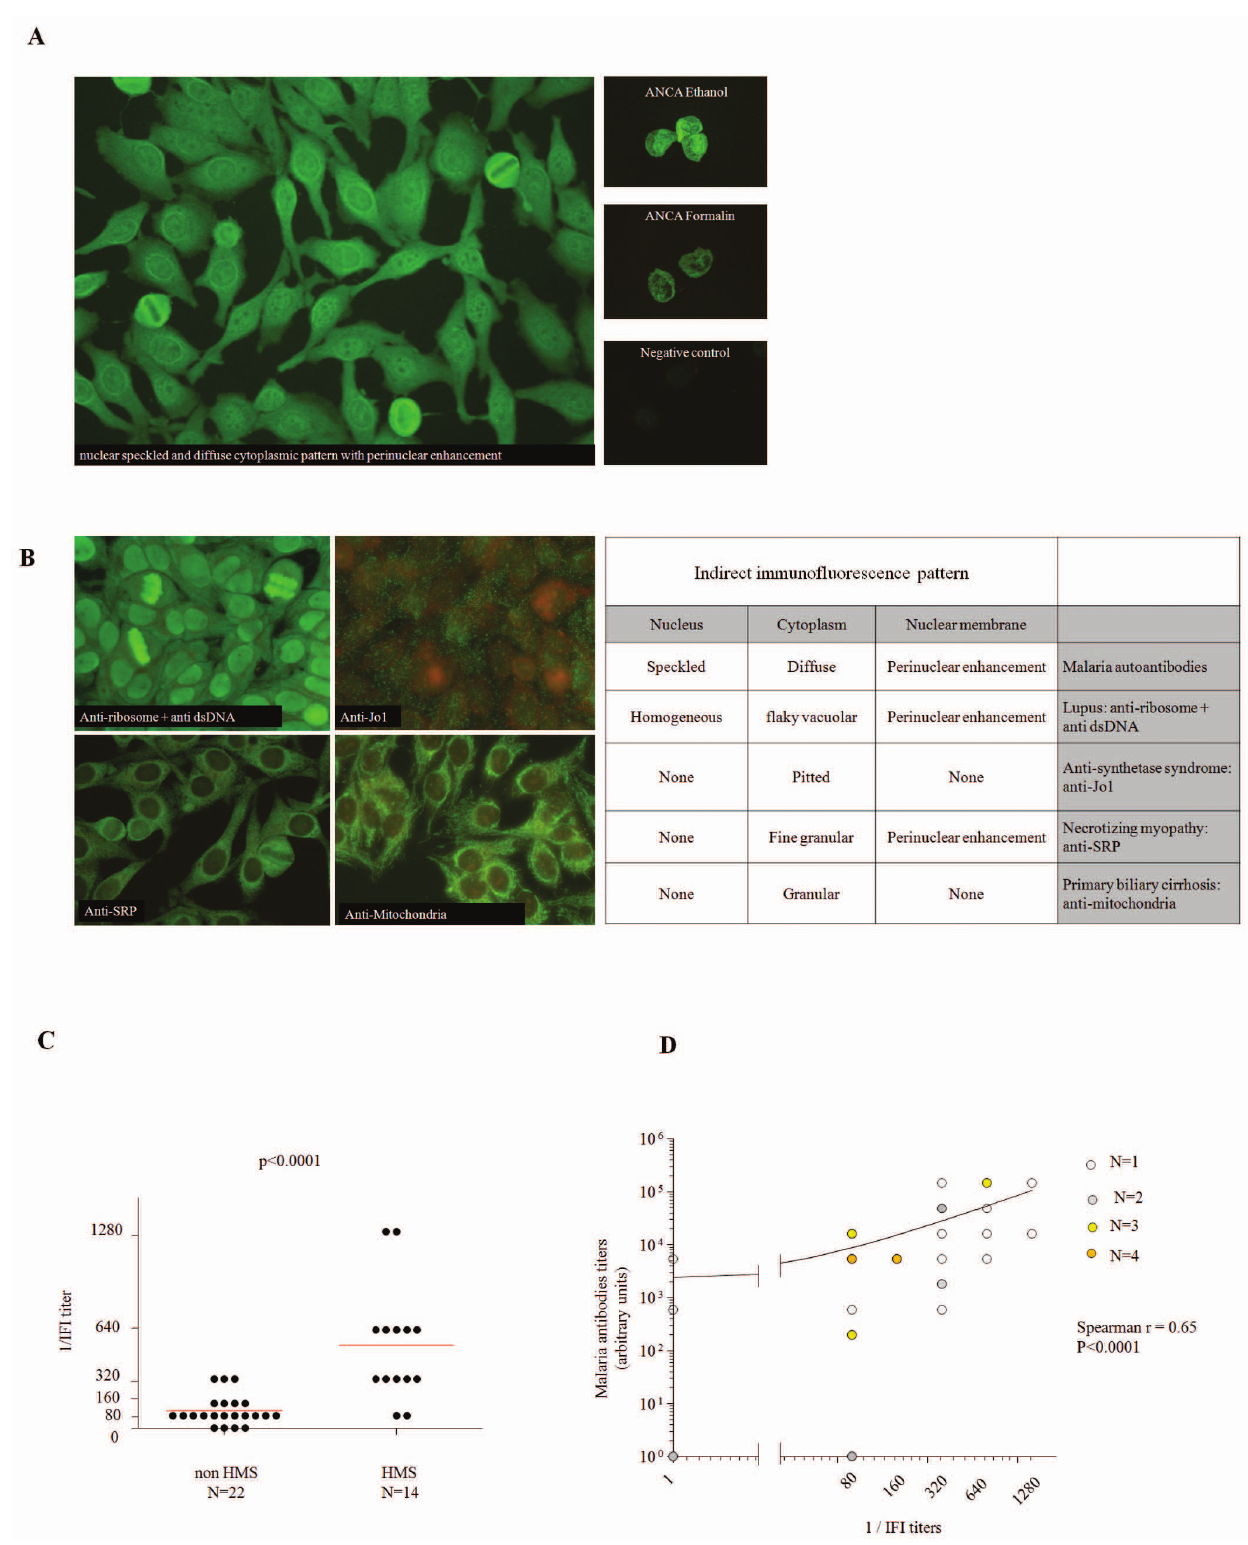
Figure 1. Distinct immunofluorescence pattern on HEp-2000 TM cells detected in the serum of patients with malaria. A Nuclear speckled and cytoplasmic diffuse pattern with perinuclear enhancement detected by indirect immunofluoresence on HEp-2000 TM cells (left) and on human neutrophils fixed with ethanol (top right) with the serum of a patient with HMS. Cytoplasmic diffuse pattern with perinuclear enhancement on neutrophils fixed with formalin. The nuclear speckled pattern is faded as observed with usual antinuclear antibodies (right middle). Negative control for ANCA testing (right bottom). B Common immunofluorescence patterns with cytoplasmic fluorescence that are diagnostic for SLE (anti-